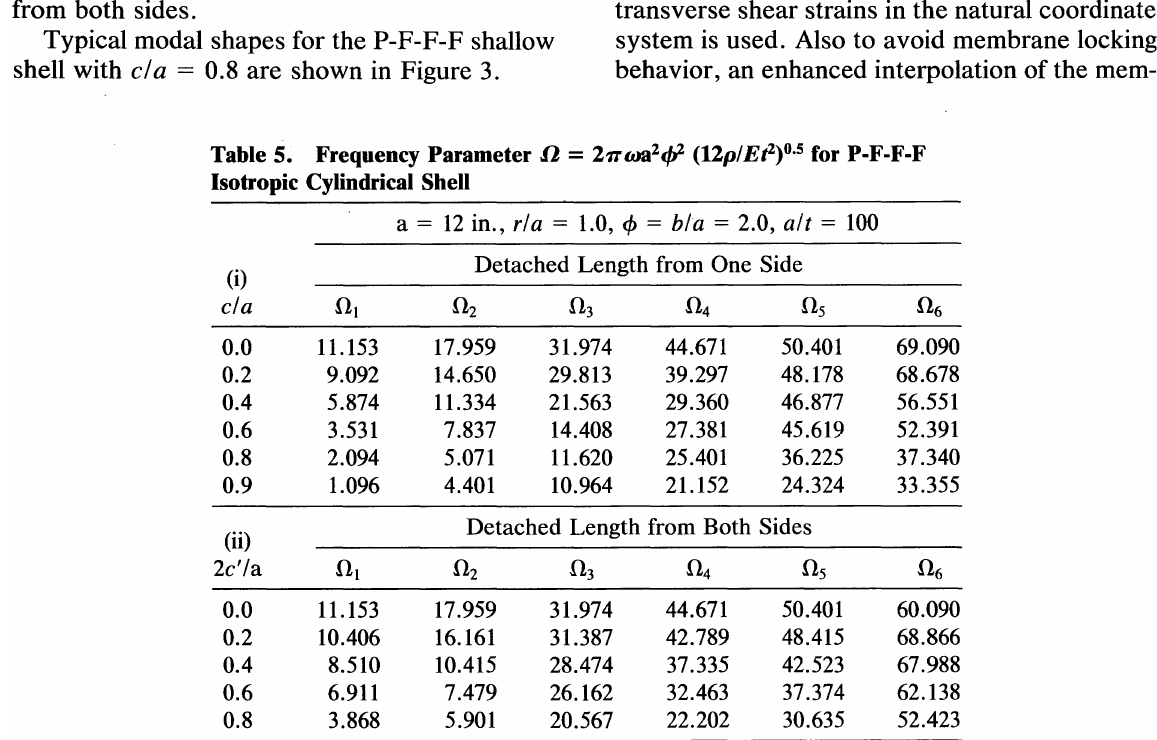
n = 2'1T(d82tf} (12pIEtl)o.s for P-F-F-F